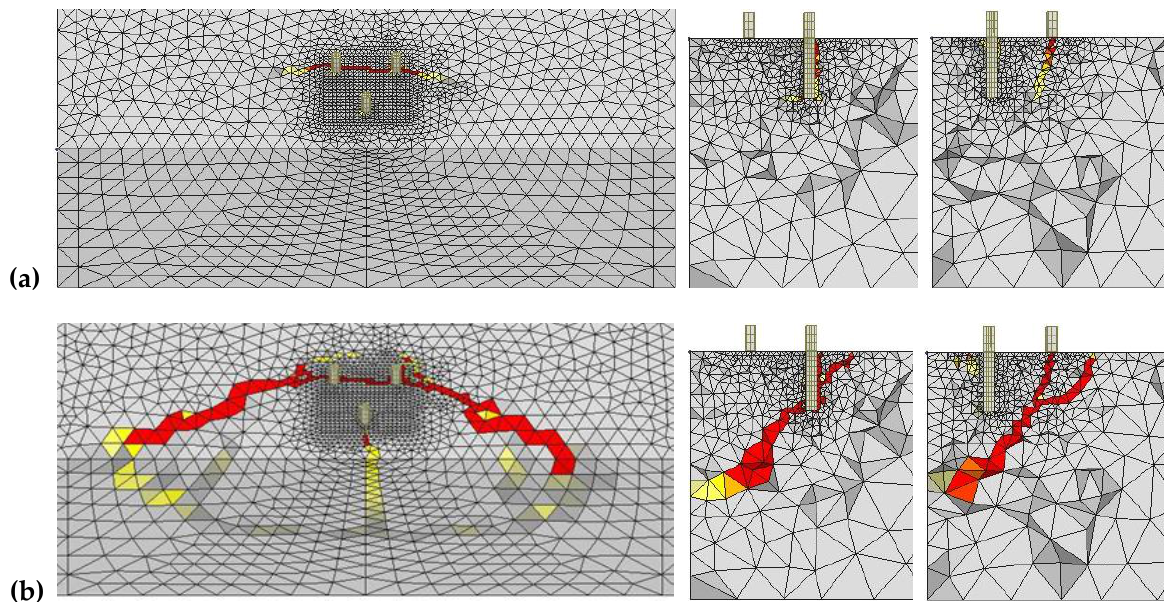
Figure 9. Crack pattern obtained from numerical analysis for Group Tri-B loaded perpendicular to the edge ( a ) at peak load, and ( b ) post-peak phase.